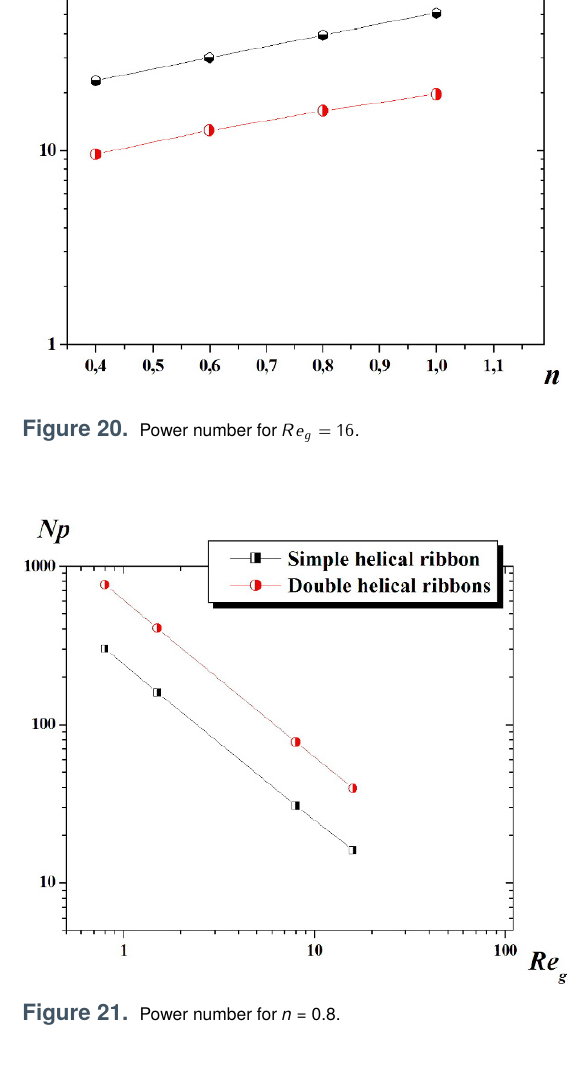
Figure 21. Power number for n =